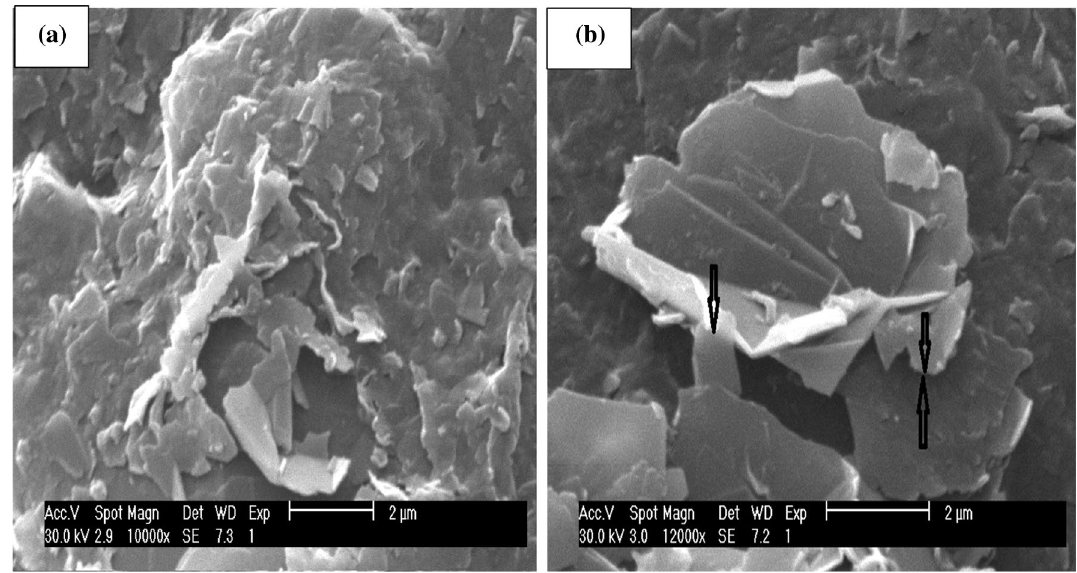
Figure 6. SEM micrographs of the graphene flakes produced at: ( a ) 70 W, ( b ) 264 W sonicator power (scale bars is 2